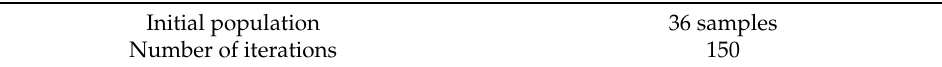
Table A2. Parameters for optimization algorithm.